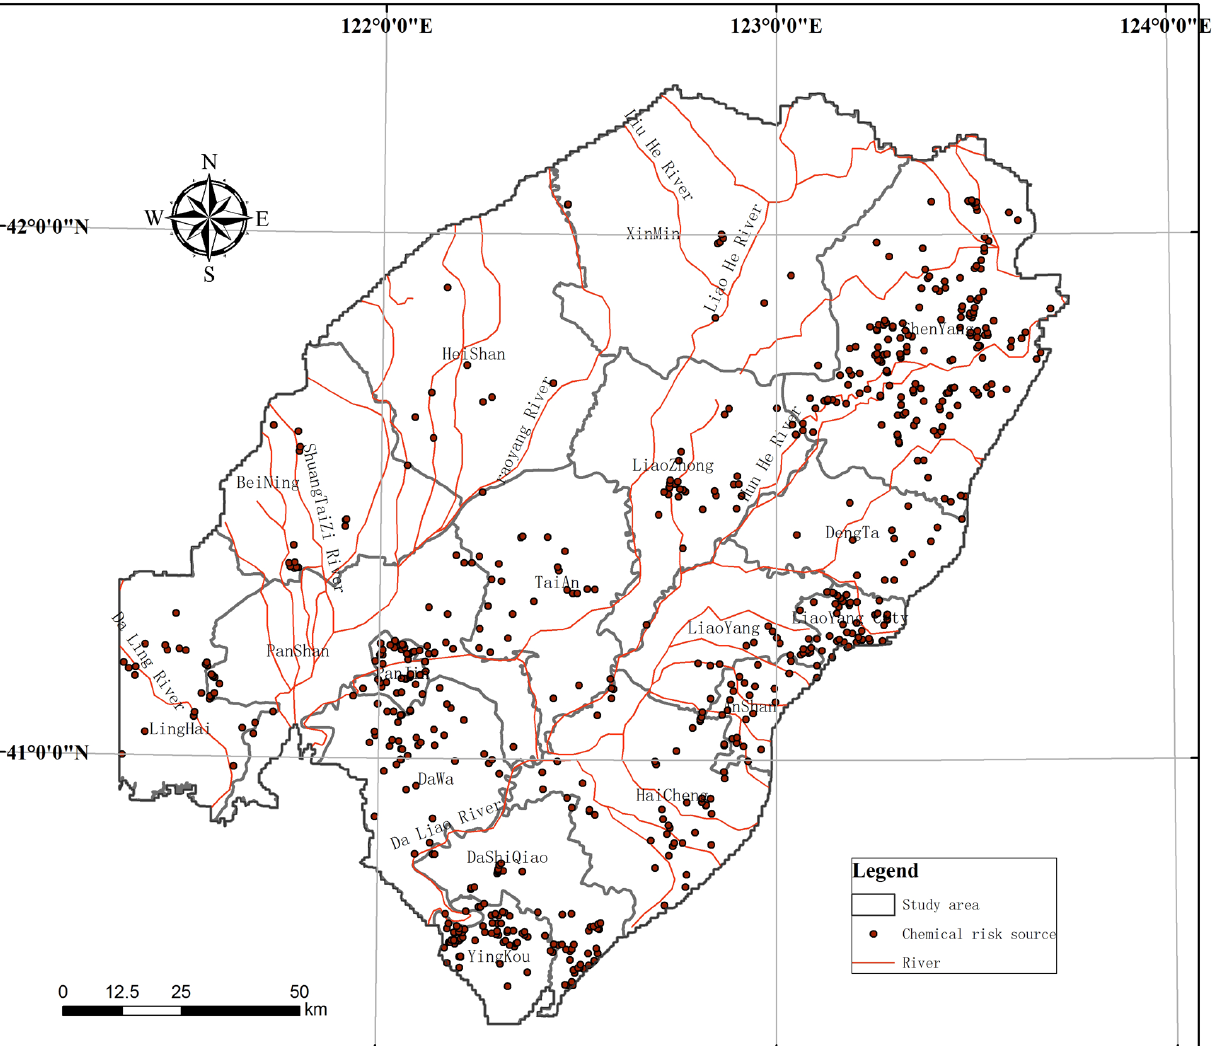
Fig 5. Distribution of the chemical enterprises in the study